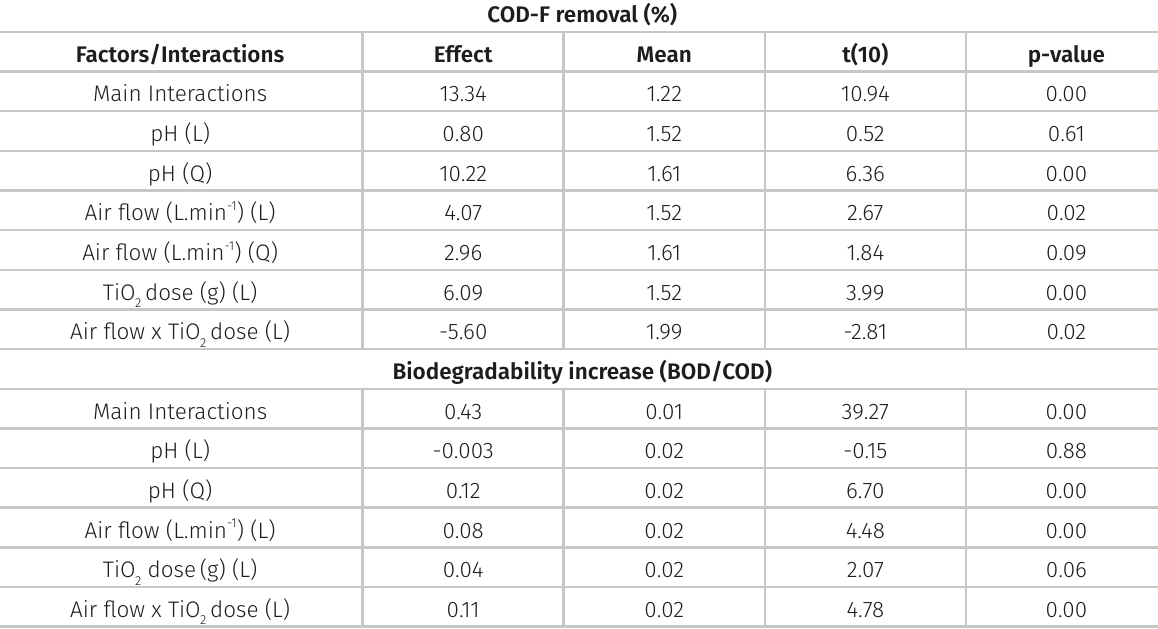
Table VII. Significant effects and interactions, standard error, degrees of freedom and p-value significance level of 95% for COD-F removal and biodegradability increase. COD-F removal